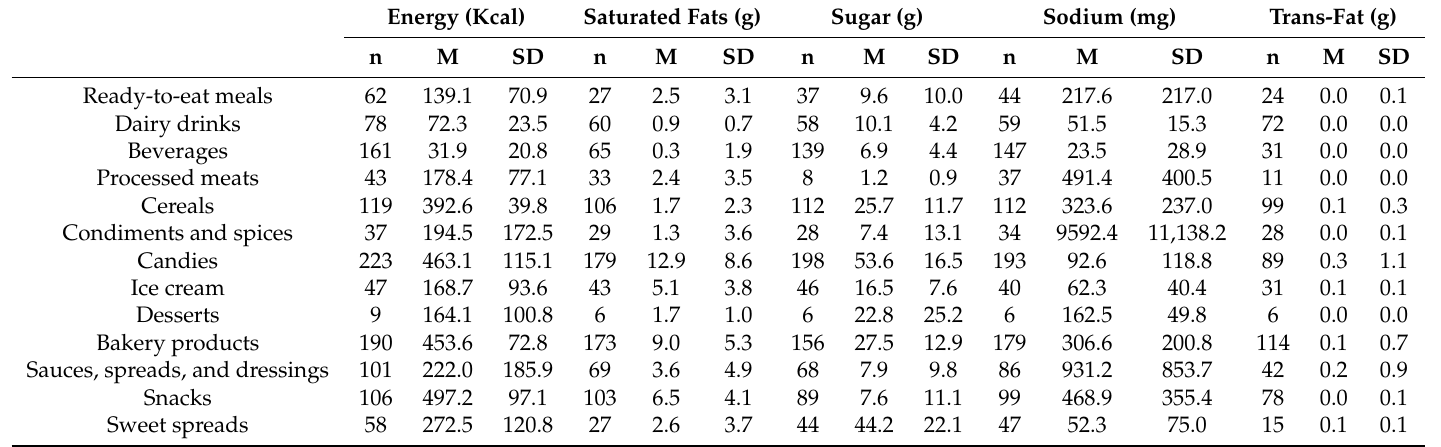
Table 2. Amount of the nutrient per 100 g / mL of